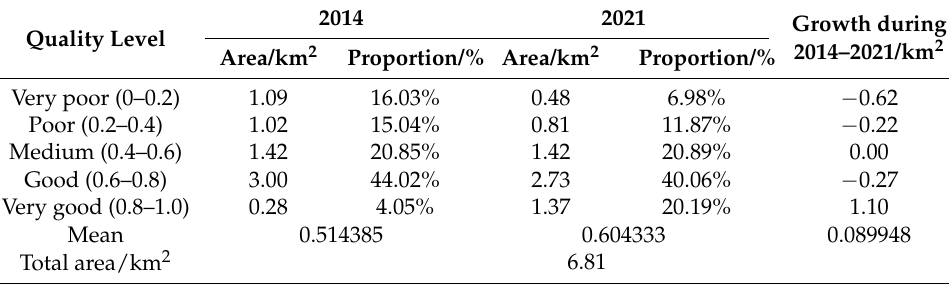
Table 2. Area and proportion of each ecological level in the study